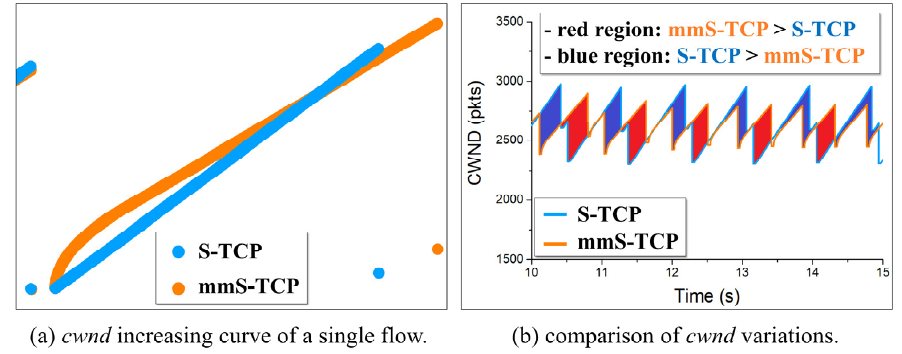
Figure 3. Cwnd change of S-TCP and mmS-TCP.